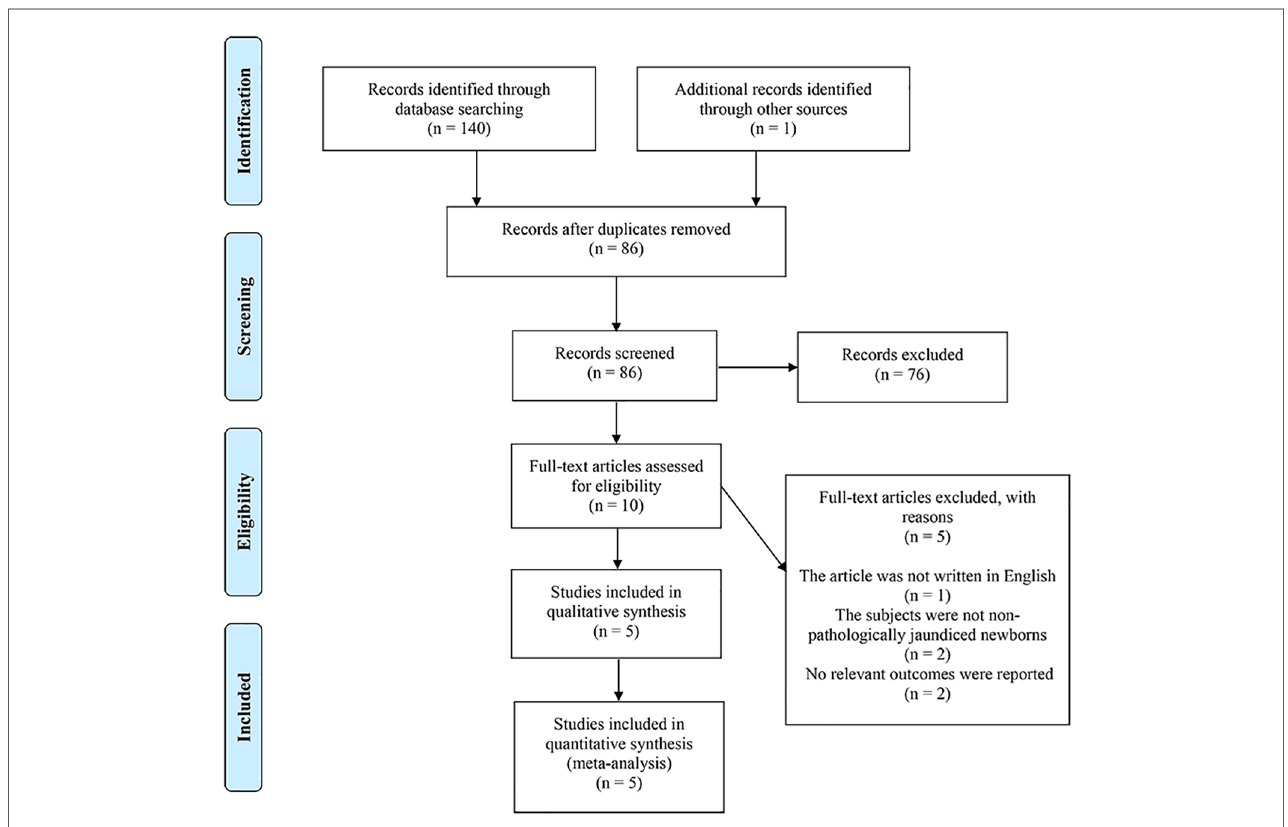
FIGURE 1 PRISMA retrieval procedures fl ow